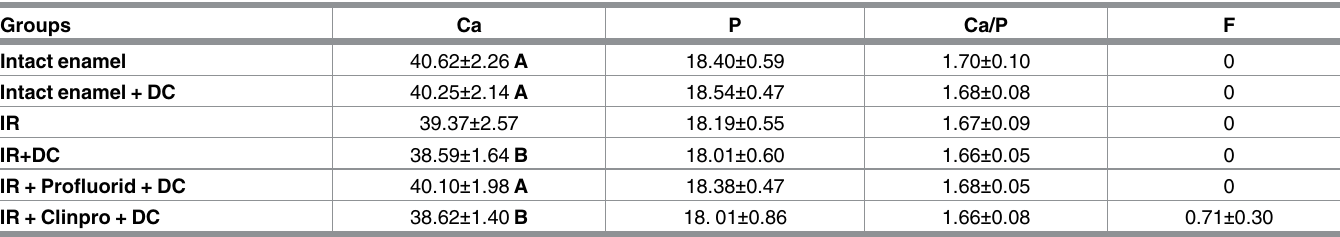
Table 2. Weight percentage (mean ± standard deviation) of calcium (Ca), phosphorous (P) and fluoride (F). Ratio Ca/P (mol/mol).